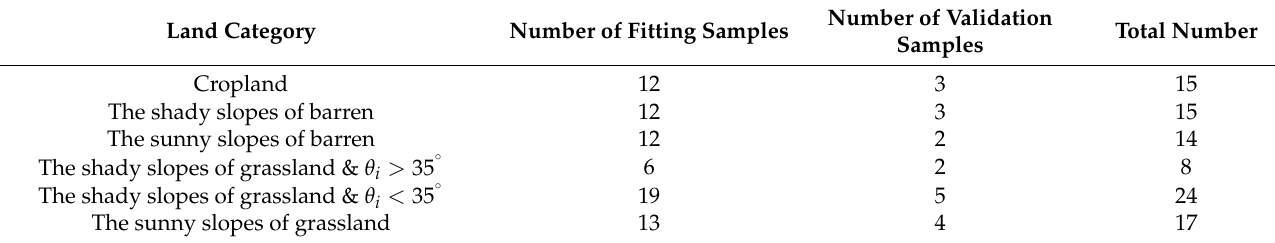
Table 3. Classification of land classes and number of observation